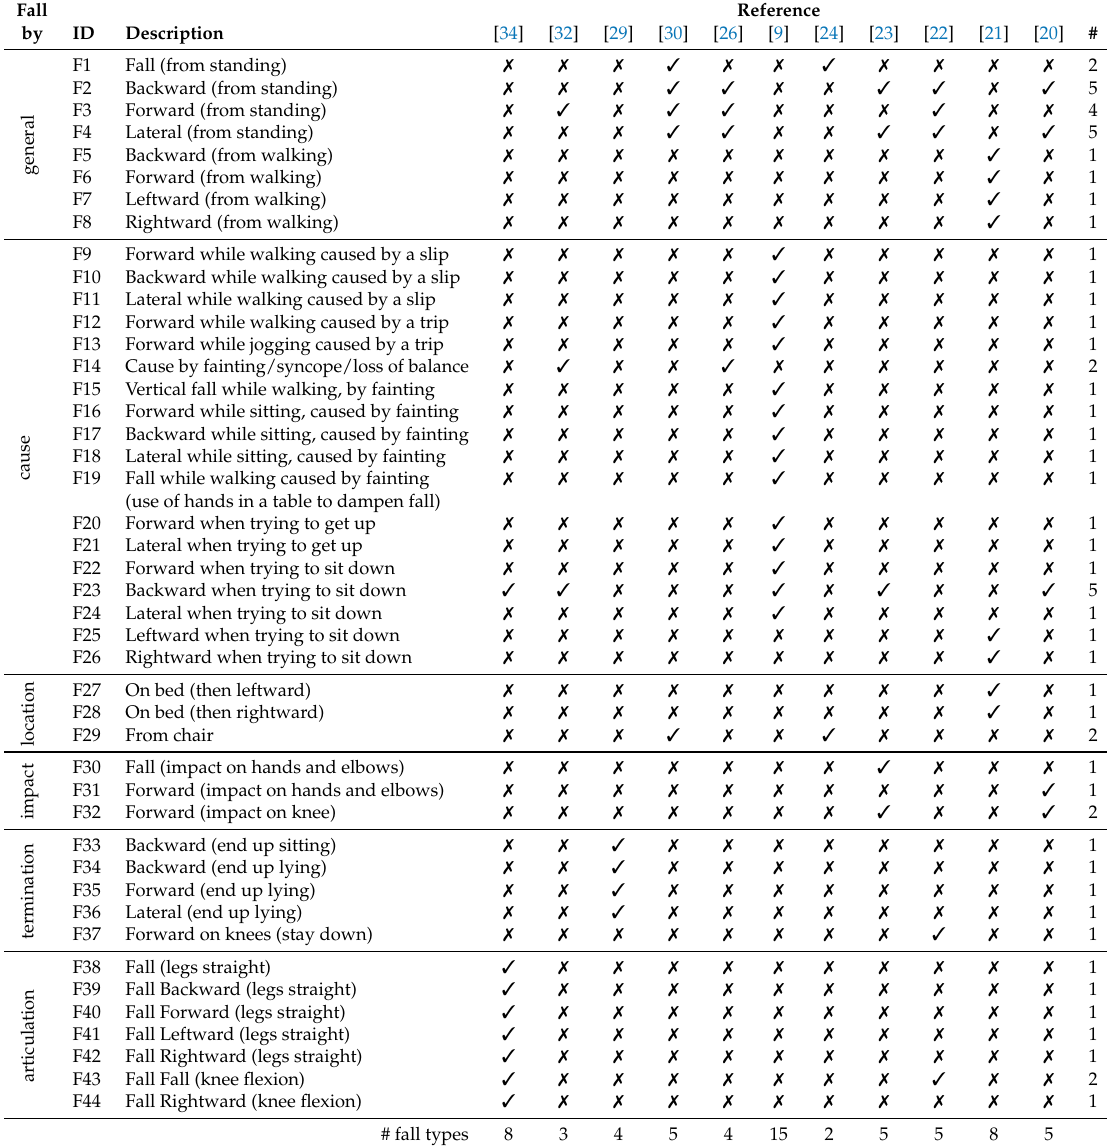
Table 3. Classification of different types of falls considered in the